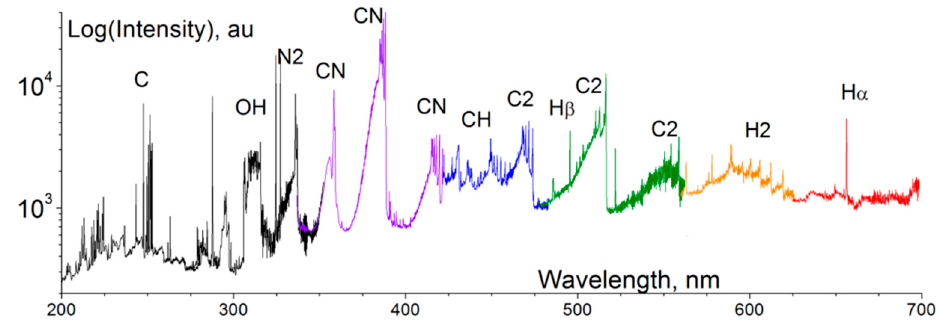
Figure 9. Composite optical emission spectrum obtained from the ethylene-airflow-plasma interaction region. Major emission lines and bands are labeled. Reprinted from [28] with permission from Elsevier.